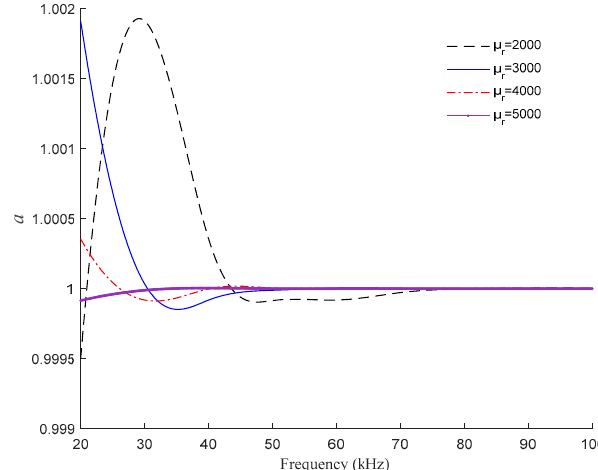
Figure 9. Variation of a with frequency under different μ r .